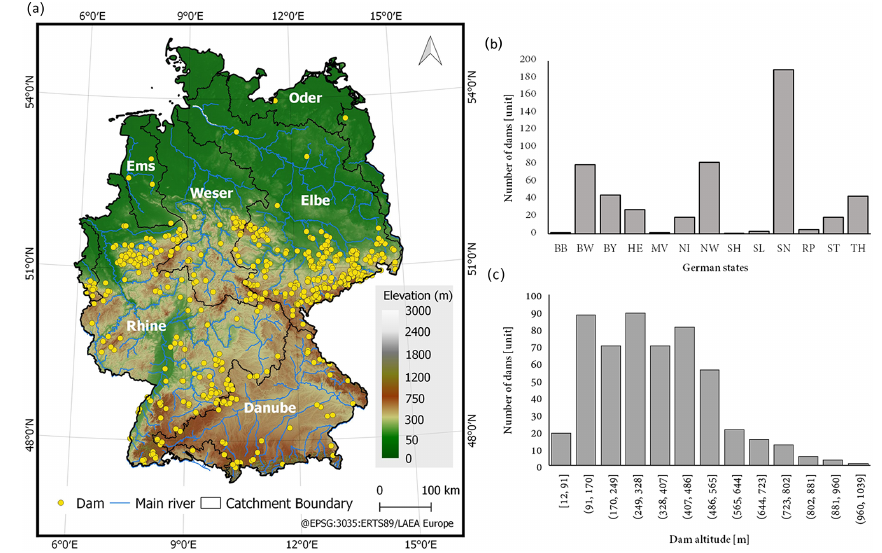
Figure 2. Dam locations across Germany (a) , number of dams in the German states (b) , and dam altitude (c) . State abbreviations are BB (Brandenburg), BW (Baden-Württemberg), BY (Bavaria), HE (Hesse), MV (Mecklenburg-Western Pomerania), NI (Lower Saxony), NW (North Rhein-Westphalia), SH (Schleswig-Holstein), SL (Saarland), SN (Saxony), RP (Rhineland-Palatinate), ST (Saxony-Anhalt), and TH (Thuringia).